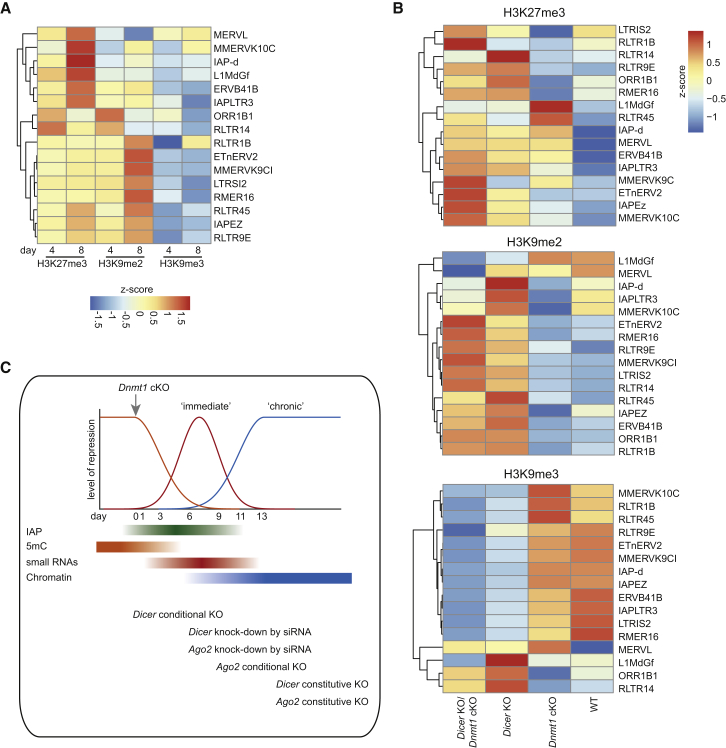
Repressive Histone Modifications Enriched at TEs upon Global Demethylation(A) Heatmap showing relative enrichment (Z score) of repressive histone marks (H3K9me3, H3K27me3, and H3K9me2) at TE classes differentially regulated upon both Dicer KO (Figure 3A) and Dnmt1 cKO (Figure 1C) and normalized to enrichment in WT ESCs upon acute deletion of Dnmt1.(B) H3K27me3, H3K9me3, and H3K9me2 enrichment over TEs dependent on Dicer and Dnmt1. Heatmap depicts ChIP-seq data of H3K27me3 mapped to TE families at depicted days after Dnmt1 cKO, Dicer KO, and Dnmt1/Dicer cDKO in comparison to WT ESCs.(C) Schematic of the two levels of TE control upon global demethylation. Upon deletion of Dnmt1, DNA methylation (5mC; orange)-mediated repression is lost, and transposon expression increases (as an example, IAP expression is shown in green). Subsequently, small RNAs (red; “immediate” response) and repressive histone marks (chromatin, blue; “chronic” response) establish a new repressive environment. Also indicated are the time points at which the different experimental manipulations interfere with the system.See also Figure S4 and Data S1.